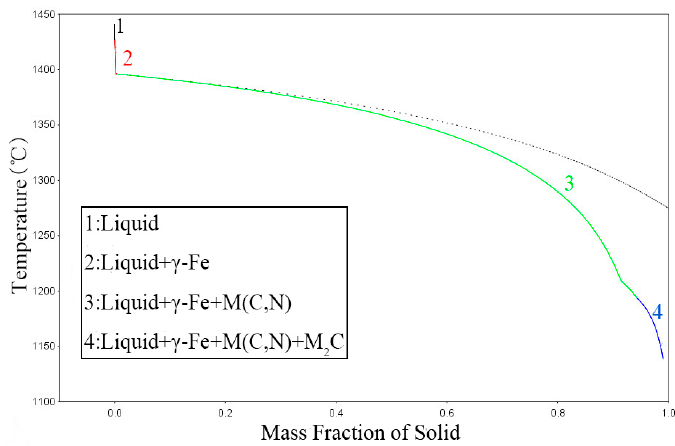
Figure 2. Nonequilibrium phase precipitation in HMAS ‐ N, calculated using Thermo ‐ Calc.